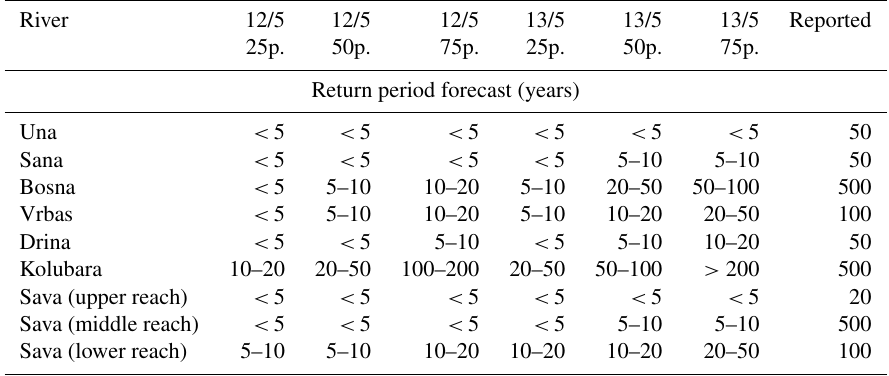
Table 6. Comparison of forecasted and observed return periods in the main rivers of the Sava basin. The Sava River has been divided into three sectors: upper, up to the confluence with the Bosna River; middle, between the confluences with Bosna and Drina rivers; and lower, from the confluence with the Drina River to the confluence into the Danube